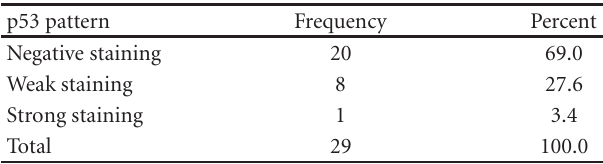
Table 5: p53 expression of nuclear staining in stroma (normal tissue surrounding the tumor) in pleomorphic adenoma.